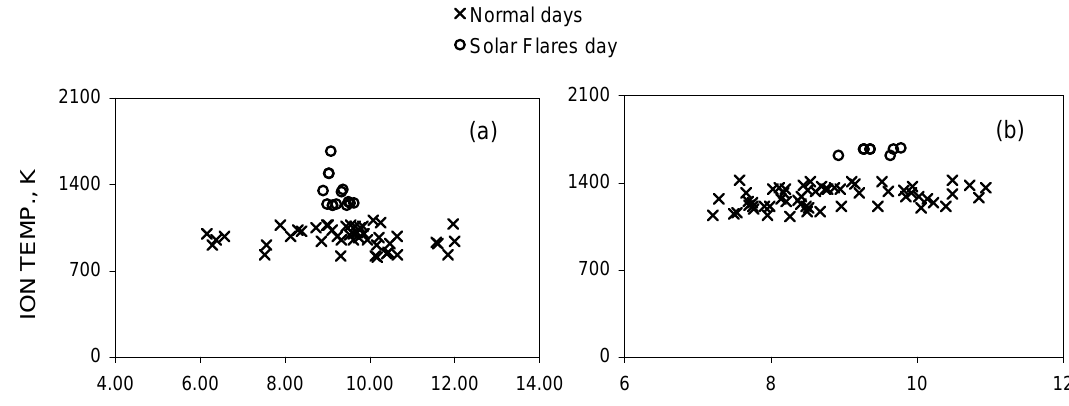
LOCAL TIME, hrs Fig. 6. Variation of ion temperature recorded by the SROSS-C2 satellite during solar flares and normal days at Pune.